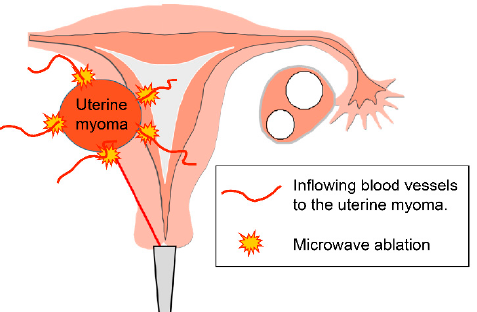
Figure 3. Schema of the procedure. After locating the inflowing vessels of the myoma under transvaginal ultrasound using a color Doppler method, direct ablation of the feeding vessels of the myoma was performed using 2.45 GHz microwave with a needle electrode. Endocrines 2022 , 3 , FOR PEER REVIEW